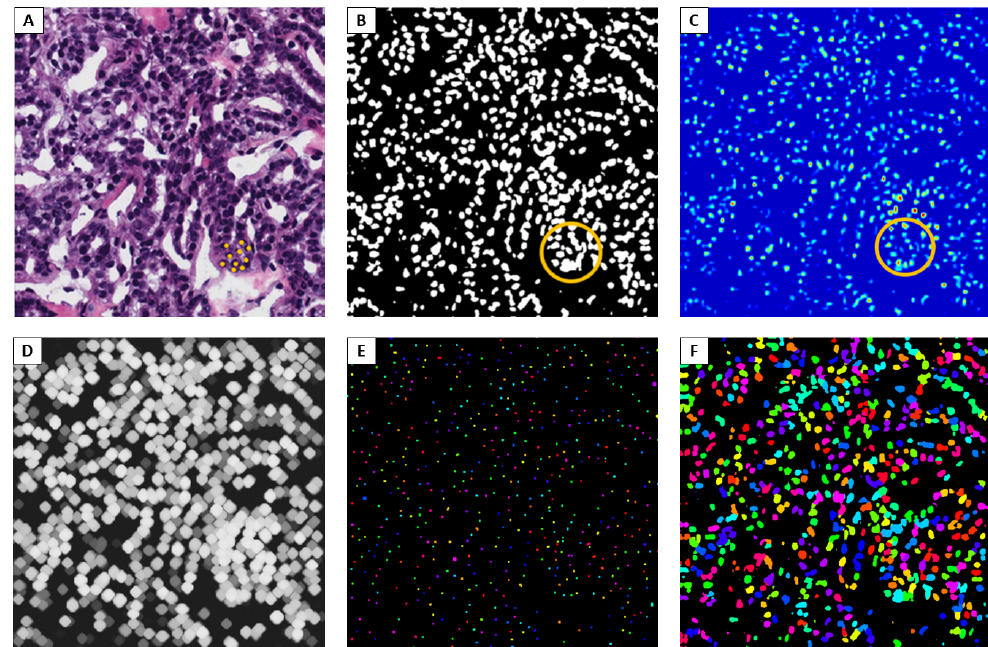
Figure 4. NDG-CAM Detection workflow. ( A ) Zone with multiple neighboring instances of nuclei. ( B ) Failure to recognize adjacent nuclei. ( C ) Grad-CAM for semantic segmentation. ( D ) Dilated image. ( E ) Connected components. ( F ) Detection